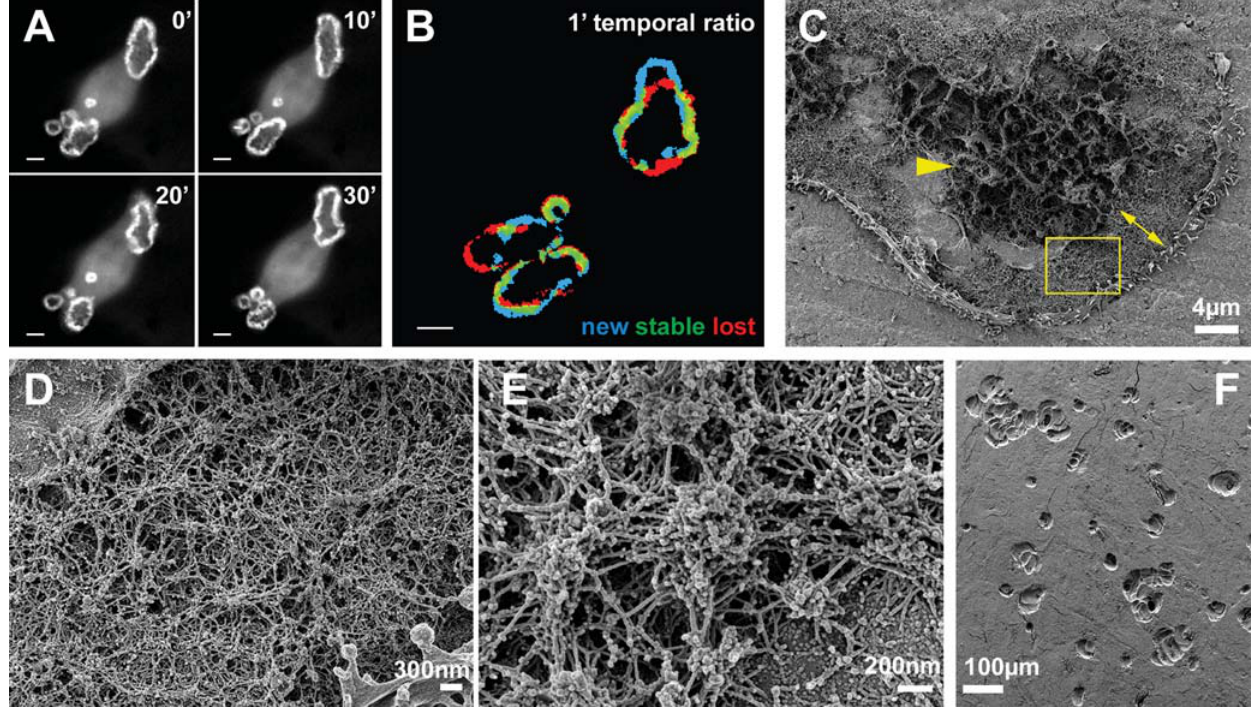
Figure 4. Sealing zone. (A, B) Frames from a movie taken by time-lapse microscopy from live GFP-actin osteoclasts plated on bone. (A) Four frames taken at 10 minutes intervals showing dynamic reorganization of actin belts. (B)One minute temporal ratio figure. Blue pixels represent new structures and red pixels faded structures. Note the high rate of dynamic reorganization. (C–E)Osteoclast ventral membrane on bone. (C) SEM overview of the ventral membrane of a cell plated on bone. The central area (arrow head) presumably corresponds to the ruffled border. The sealing zone (double arrow) is thicker than on glass. (D, E) Higher magnification views (from yellow box in (E)) of the podosomes forming the sealing zone. (F) Osteoclasts were plated on bone slices and removed three days later, leaving numerous resorption pits on the